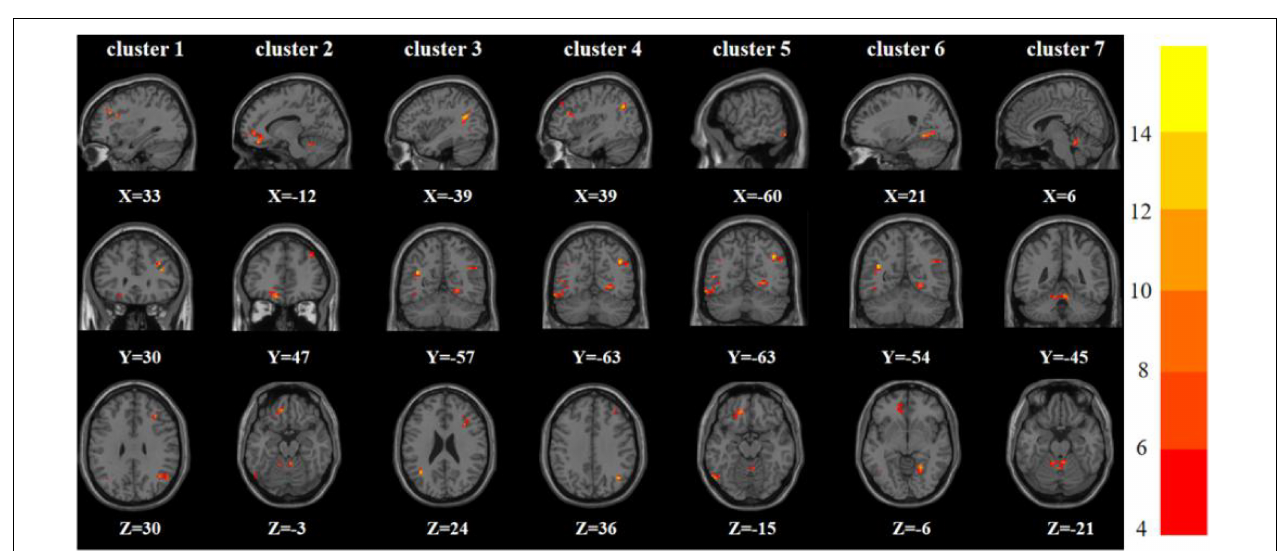
FIGURE 1 | Brain regions with abnormal ReHo among the three groups based on one-way analysis of variance. The color bars indicate the F -value.